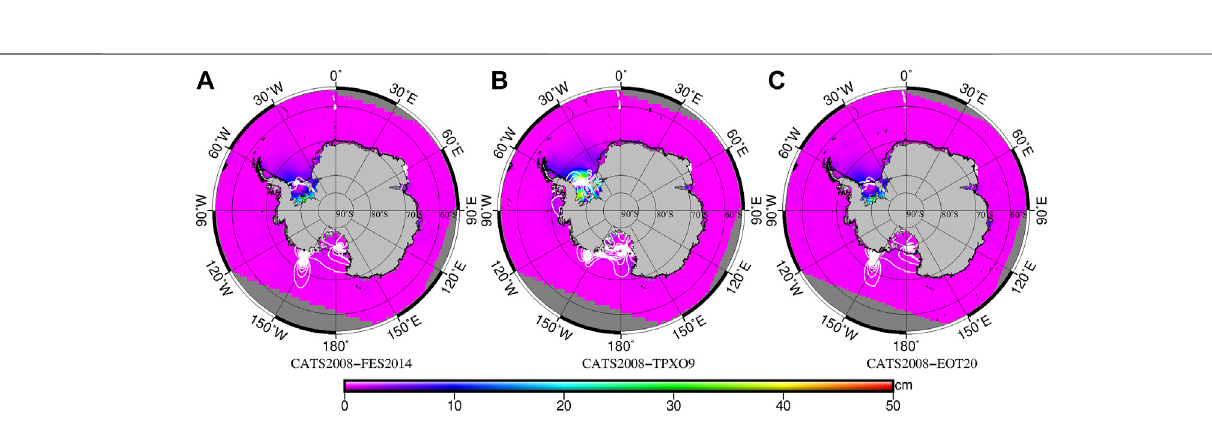
FIGURE 4 | Difference of the M2 constituent between (A) CATS2008 and FES2014, (B) CATS2008 and TPXO9, and (C) CATS2008 and EOT20. The color scale represents the amplitude value; white contour lines represent the phase lag ( ° ).